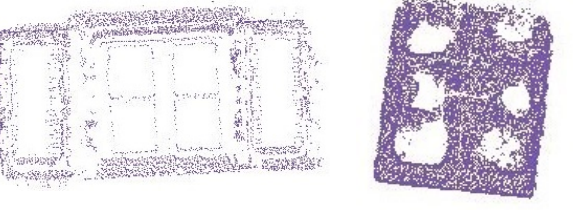
Figure 10 . Some magnified segregated patches. Figure 10. Some magnified segregated